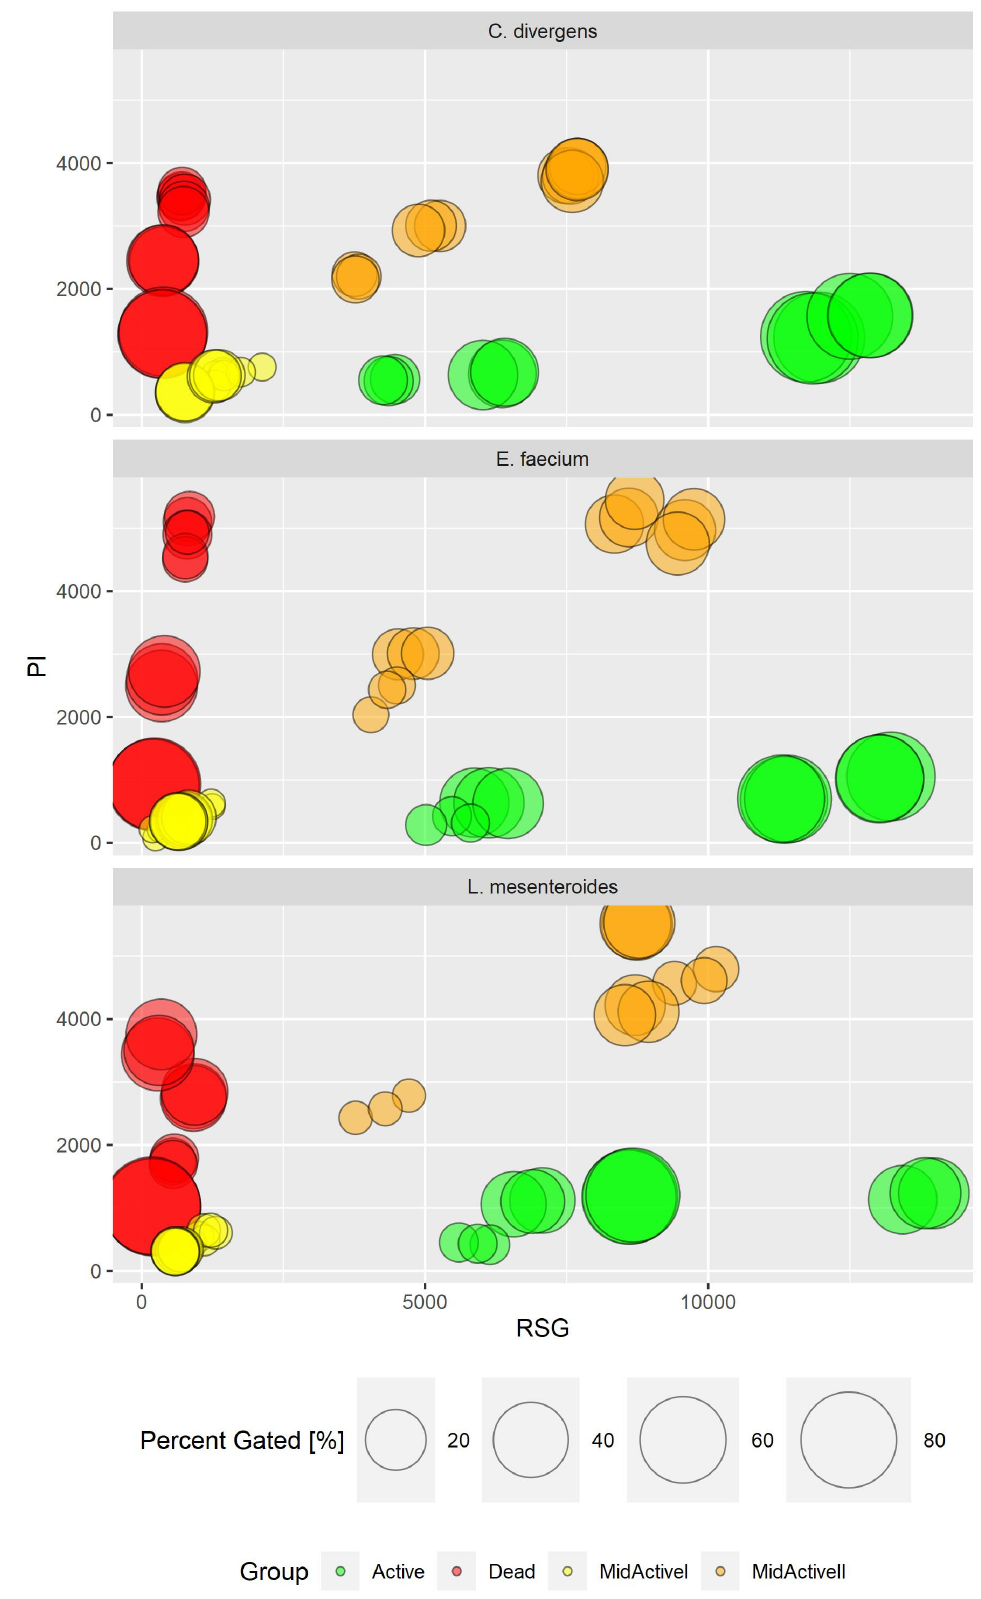
Figure 9. Subpopulation distribution in different strains by PI and RSG signal value (in RFU—relative fluorescence units). Comparison of results for all experiments.